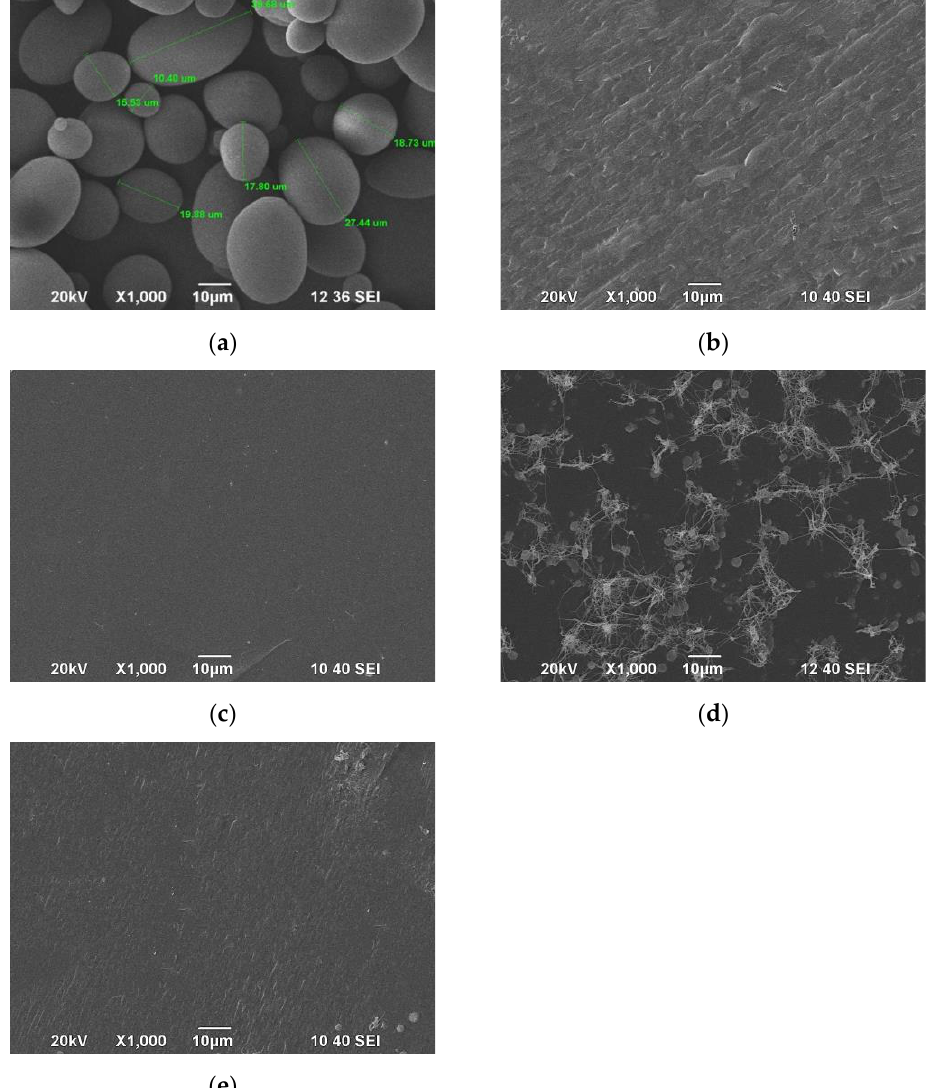
Figure 7. SEM images of native starch ( a ), TPS ( b ), TPS/HNT ( c ), TPS/PP-HNT ( d ) and TPS/G-HNT ( e ).